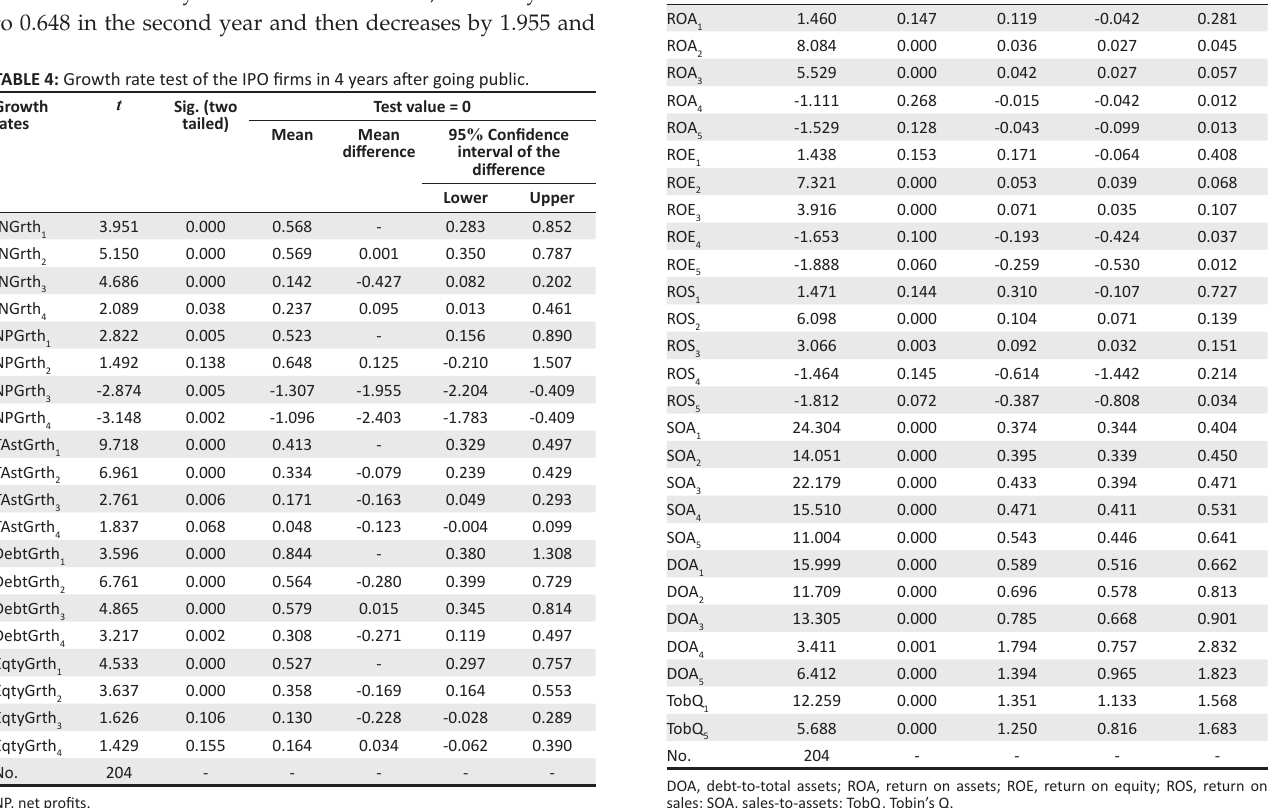
TABLE 5: Test of performance sustainability of the IPO firms over the 5 years after going public. t Sig. (two Indicators t tailed)